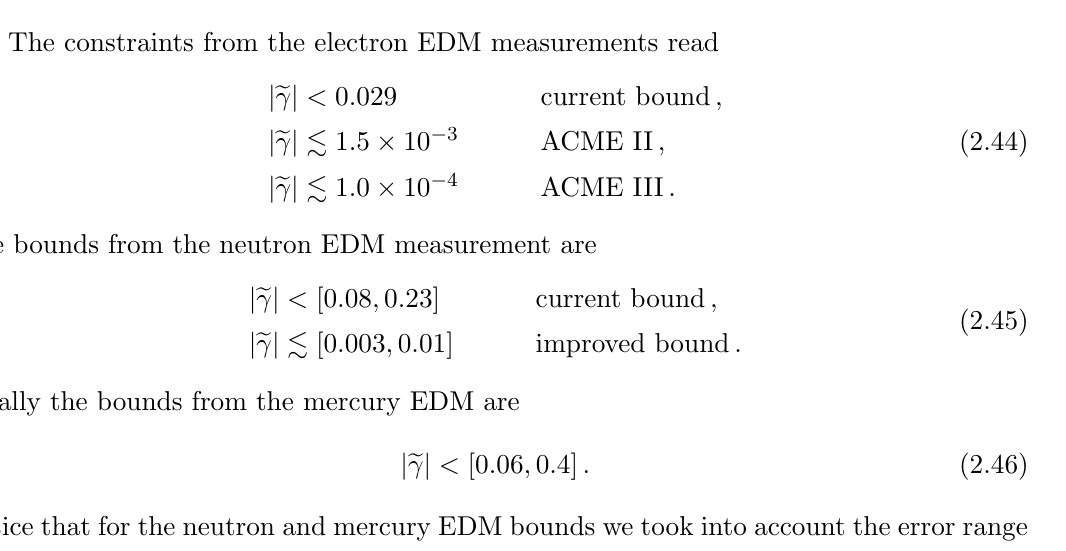
Figure 5 . Bounds on the mass of the T (left panel) and X (right panel) states derived from 5 = 3 the constraints on the electron EDM. The bounds are expressed in TeV and are presented as a function of the elementary-composite mixing y L 4 and of the imaginary part of c t . The labels on the left vertical axis corresponds to the present bounds, while the ones on the right axis correspond to the ACME III projections. The solid and dashed lines correspond to the choice (cid:24) = 0 : 1 and (cid:24) = 0 : 05